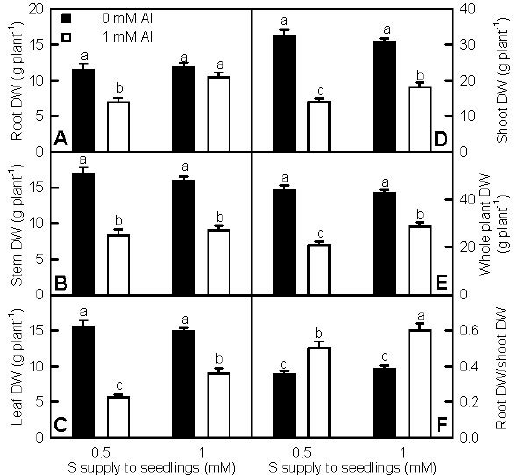
Figure 1. Effects of sulfur(S) and aluminum(Al) interactions on root ( A ), stem ( B ), leaf ( C ), shoot ( D ), and whole plant ( E ) dry weight(DW), and root DW/shoot DW ratio ( F ) in C. grandis seedlings. Bars represent means ± SE ( n = 15). Differences among the four treatments were analyzed by two (Al levels) × two (S levels) ANOVA. Different letters indicate a significant difference at p < 0.05.